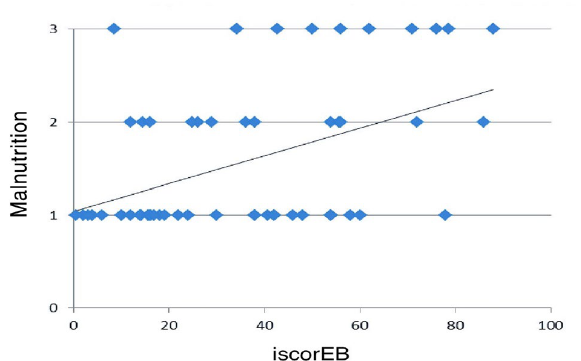
Figure 2. Scatter plot showing the correlation between iscorEB and malnutrition. (Y axis—3-severe malnutrition, 2-moderate malnutrition, 1-mild/ no